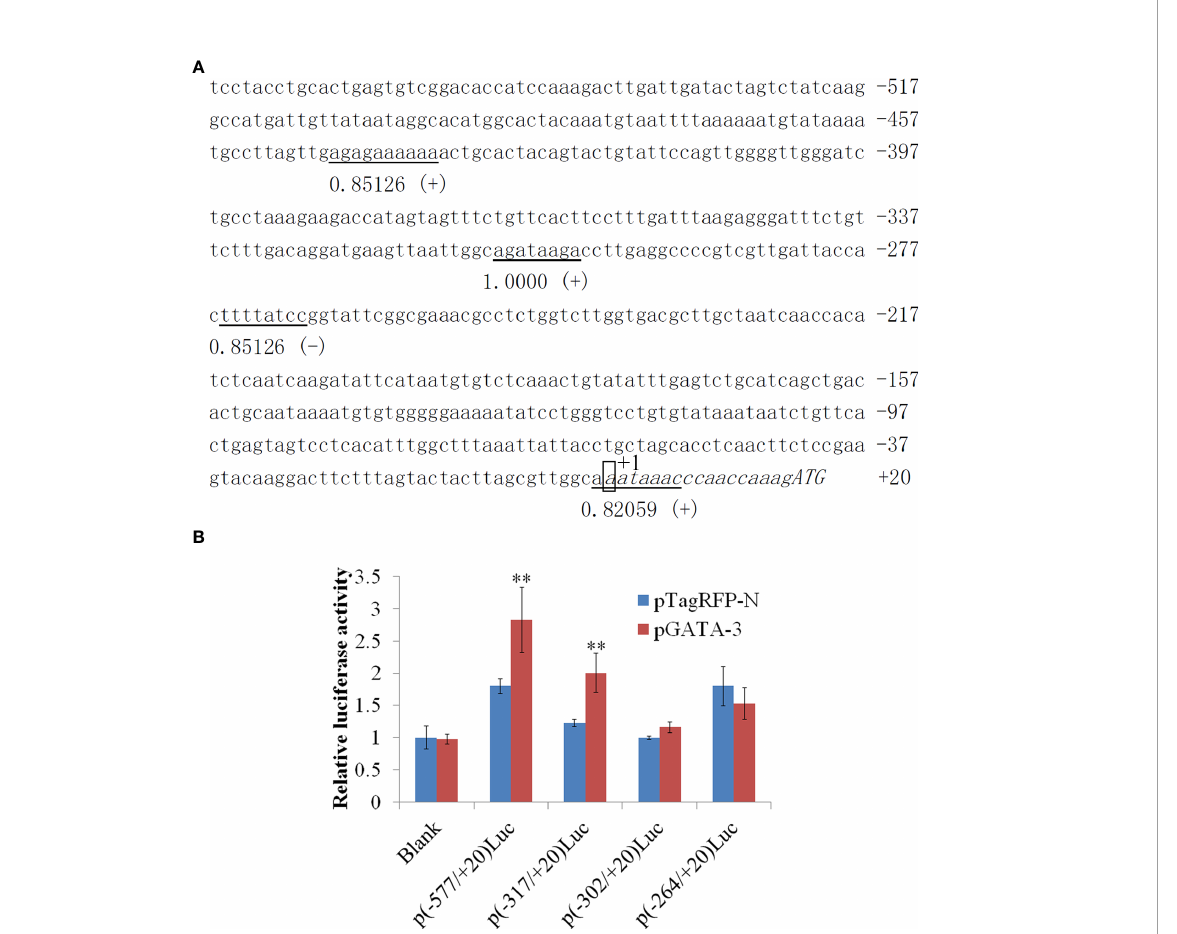
FIGURE 3 The sequence and activity of salmon IL-4/13a promoter. (A) The nucleotide sequence of promoter regions (557 bp) was obtained. The transcription start site is designated as +1 and boxed. Transcription factor binding sites were predicted by MatInspector and TRANSFAC ® . Consensus elements of transcription factor binding sites are underlined. The number under horizontal lines indicates matrix similarity. The symbol (+) indicates the binding sites identi fi ed on the positive strand, whereas the symbol (-) indicates the opposite. (B) CHSE-214 cells were transfected by pLuc Ss IL-4/13a reporter vectors with p Ss GATA-3 or pTagRFP-N. pSeap-Control performed as a normalized control. Luciferase activity is expressed relative to SEAP (mean ± SD from six wells). Double asterisks (**) above bars indicate signi fi cant differences ( P < 0.01). Data are from six wells of cells per treatment in one experiment and represent three independent